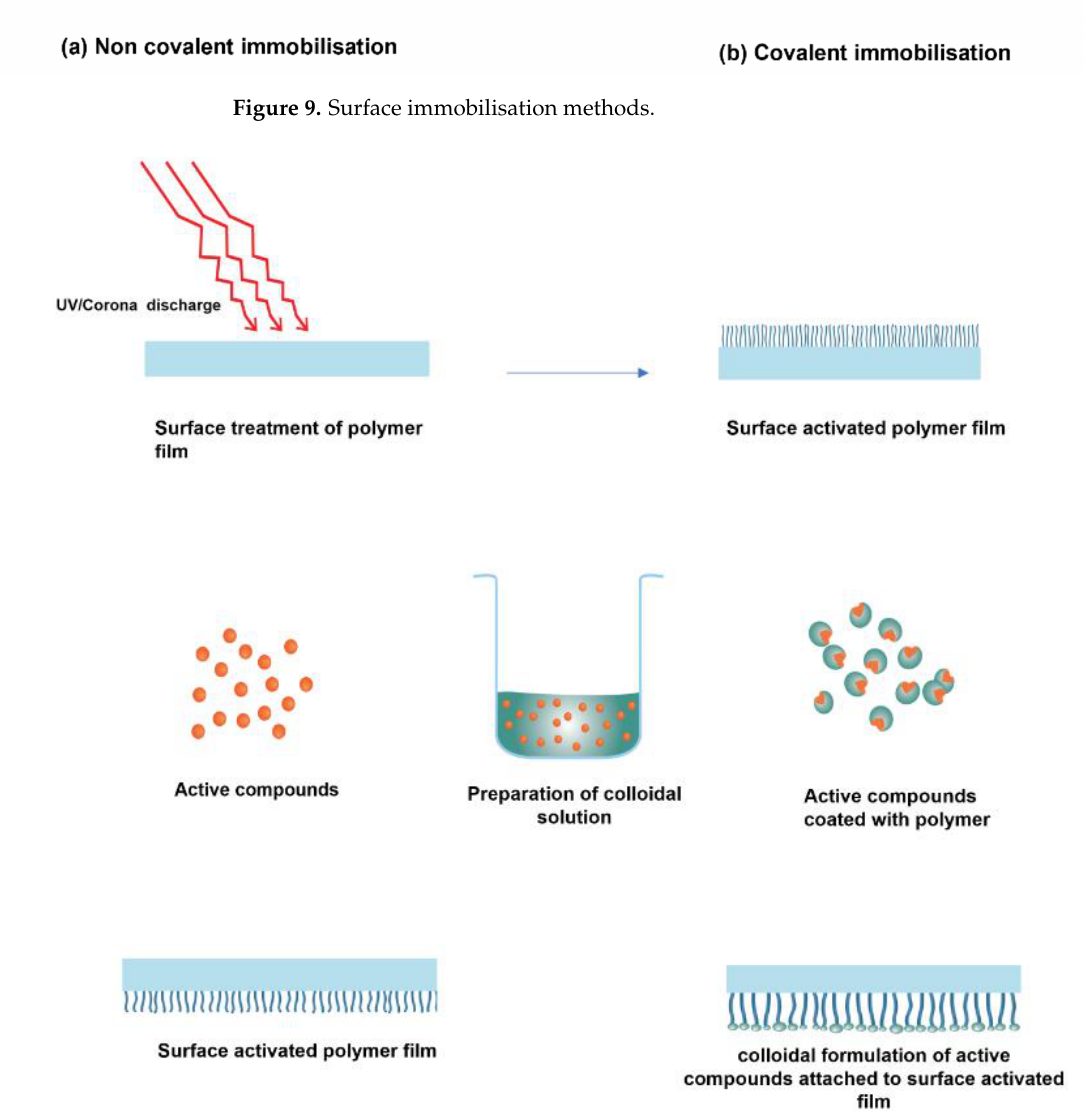
Figure 10. Schematic representation of covalent grafting of colloidal